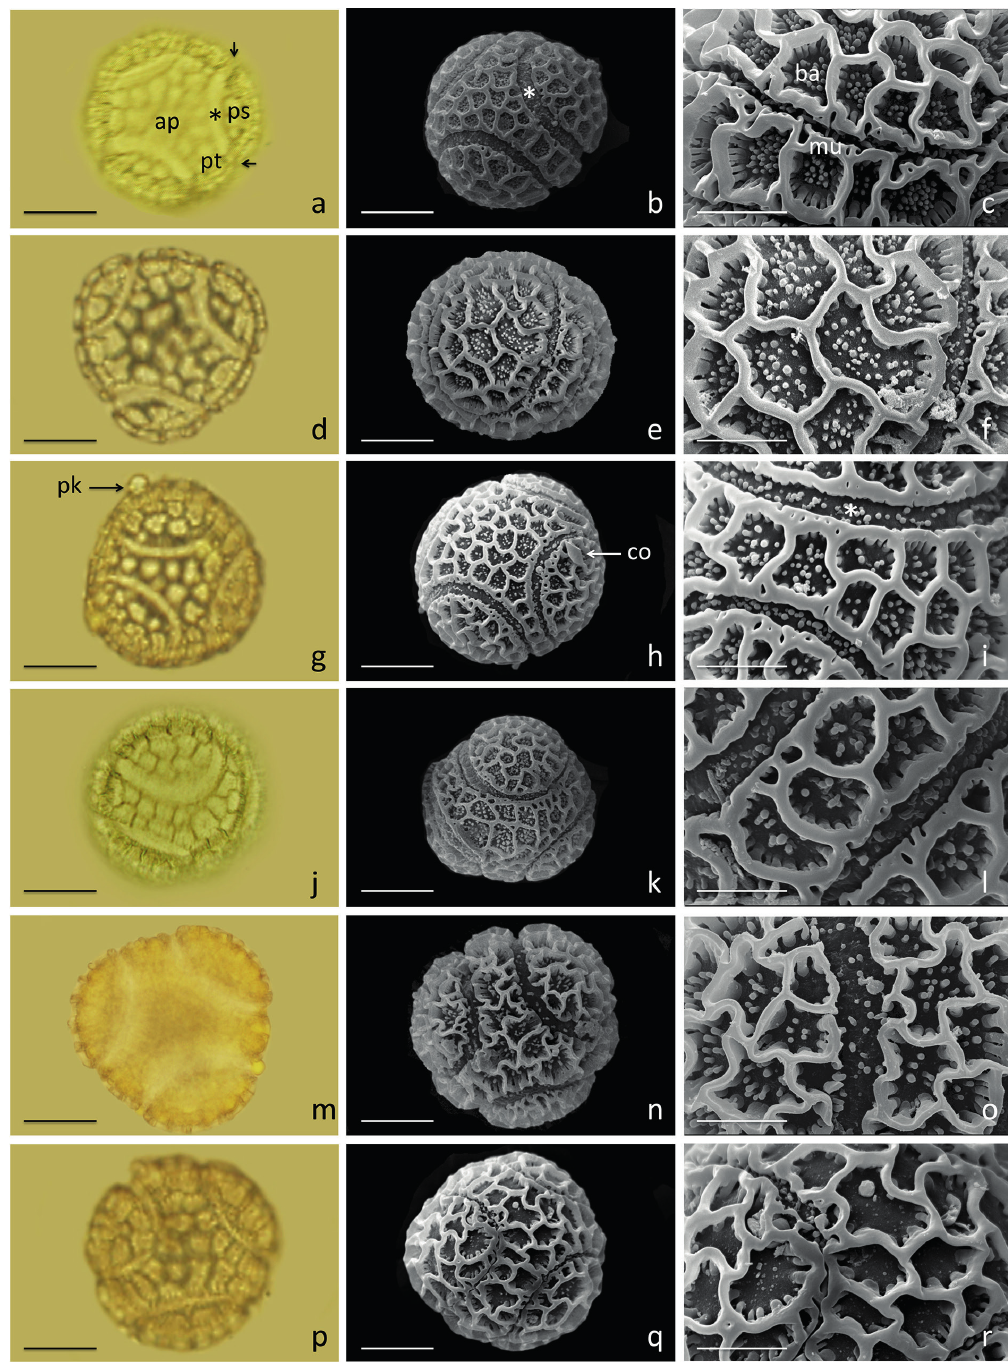
Figure 3 - Pollen grains of Passiflora using a light microscope (LM) and a scanning electron microscope (SEM). a-c ) P. maliformis (BGP-379); d-f ) P. alata (BGP-004); g-i ) P. gibertii (BGP-008); j-l ) P. subrotunda (BGP-394); m-o ) P. foetida (BGP-153); p-r ) P. edulis (BGP-038); a, d, g, j, m, p) LM overview; b, e, h, k, n, q) SEM overview; c, f, i, l, o, r) details of the exine and colpi using an SEM. ap: apocolpus; ba: bacula; co: calcium oxalate crystals; mu: muri; pk: pollenkitt; ps: pseudoperculum; pt: pontoperculum; arrow: apertures; *fusion of the apertures within the apocolpus. Bars: a, b, d, e, g, h, j, k, m, n, p, q = 20 μm; c, f, i, l, o, r = 10